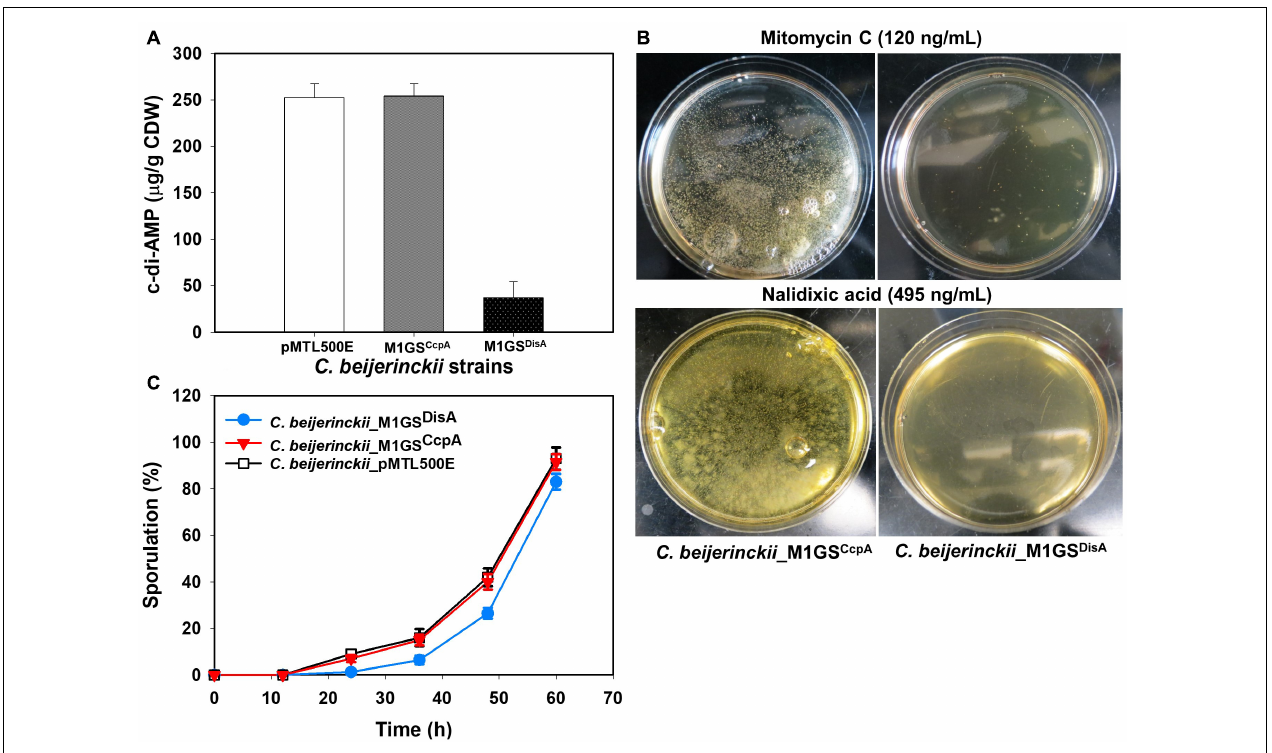
FIGURE 3 | Phenotypic changes elicited by M1GS DisA . (A) Intracellular c-di-AMP levels in C. beijerinckii _M1GS DisA decreased 7-fold relative to C. beijerinckii _M1GS CcpA and _pMTL500E at 24 h of growth. CDW, cell dry weight. (B) C. beijerinckii _M1GS DisA was more sensitive to mitomycin C and nalidixic acid than C. beijerinckii _M1GS CcpA . At the specified concentrations, both antibiotics caused ∼ 100% loss of cell viability in C. beijerinckii _M1GS DisA (see Supplementary Figure 1 for more details). Generation of carbon dioxide and hydrogen during cellular growth and metabolism caused bubbles on C. beijerinckii _M1GS CcpA plates. (C) Sporulation profiles of C. beijerinckii _M1GS DisA relative to C. beijerinckii _M1GS CcpA and _pMTL500E. Error bars represent standard deviation of the mean ( n =